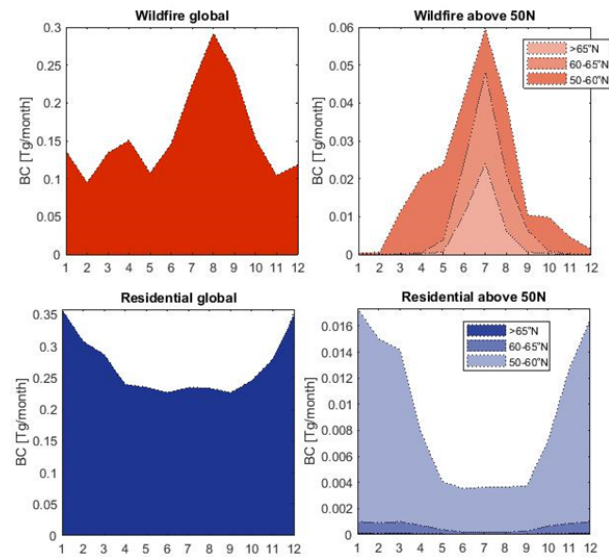
Figure 7. Monthly black carbon emissions from the leading anthro- pogenic sector, residential heating, in GAINS and wildfires from GFAS based on global estimates (left) and by latitudinal ranges (right); emissions are averaged from the given years of 2010, 2015 and 2020 to align with the GAINS data